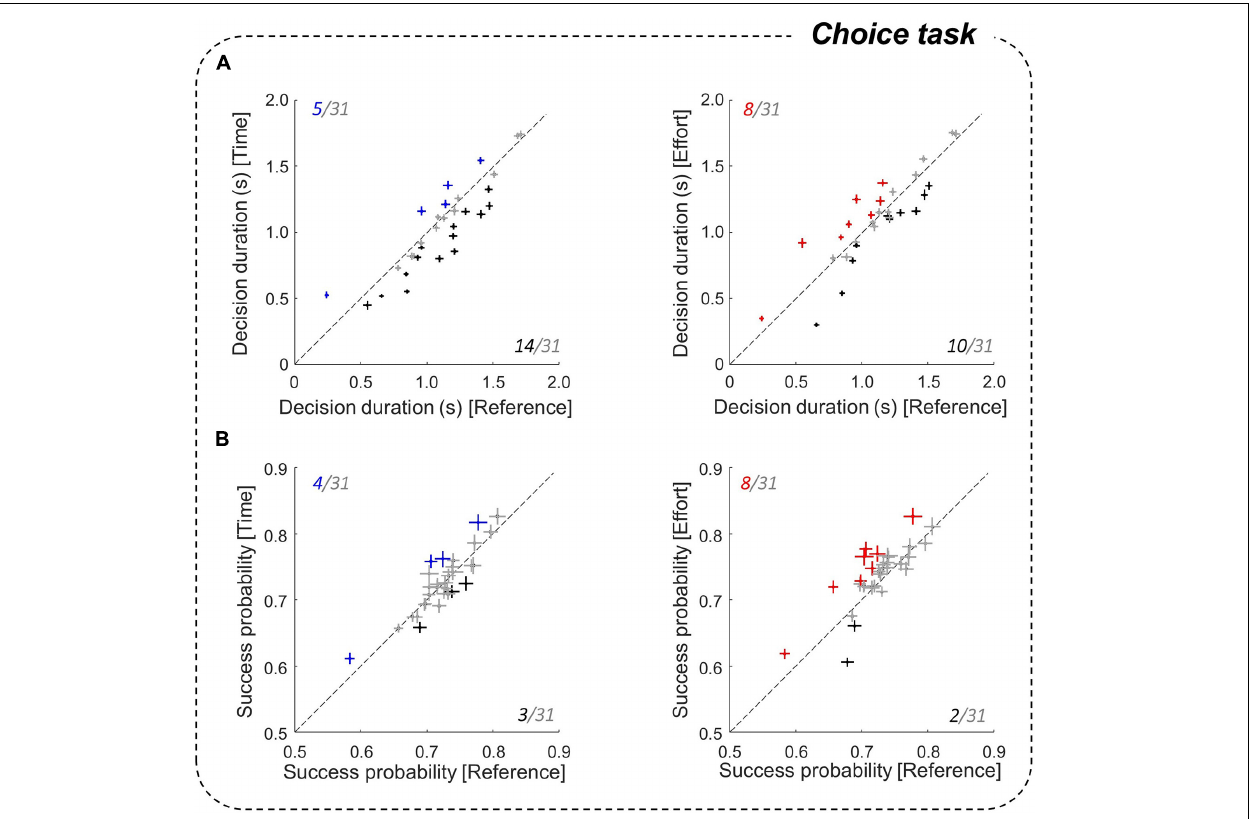
FIGURE 4 | Effect of motor conditions on decision duration and success probability. (A) Comparison of the mean ( ± SE) subjects’ decision durations between the costly conditions (left panel: Time/right: Effort) and the Reference condition in the choice task. Same conventions as in Figure 3 . (B) Same analysis as A for success probabilities at decision